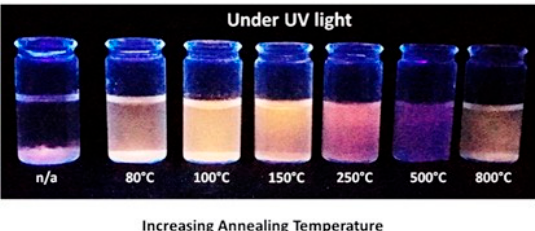
Figure 7. Photoemission colors under 365 nm UV lamp light of the dispersion solutions of ZnO NP after annealing at different temperatures (from 80 to 800 °C).